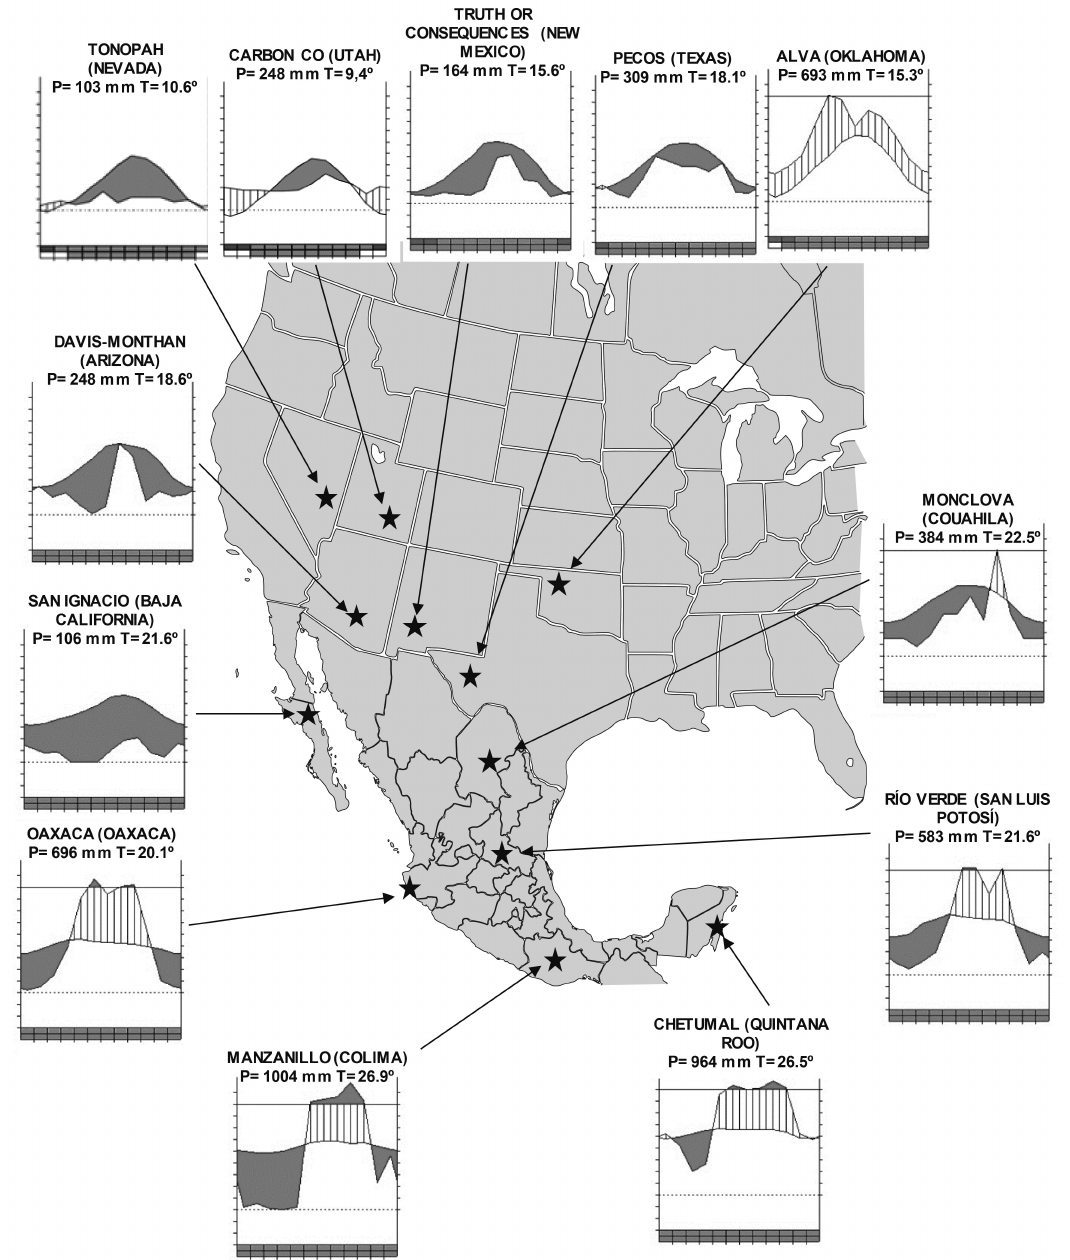
Figure 7. Bioclimatic diagrams of different localities with flora linked to gypsum substrates, from North America (Retrieved from